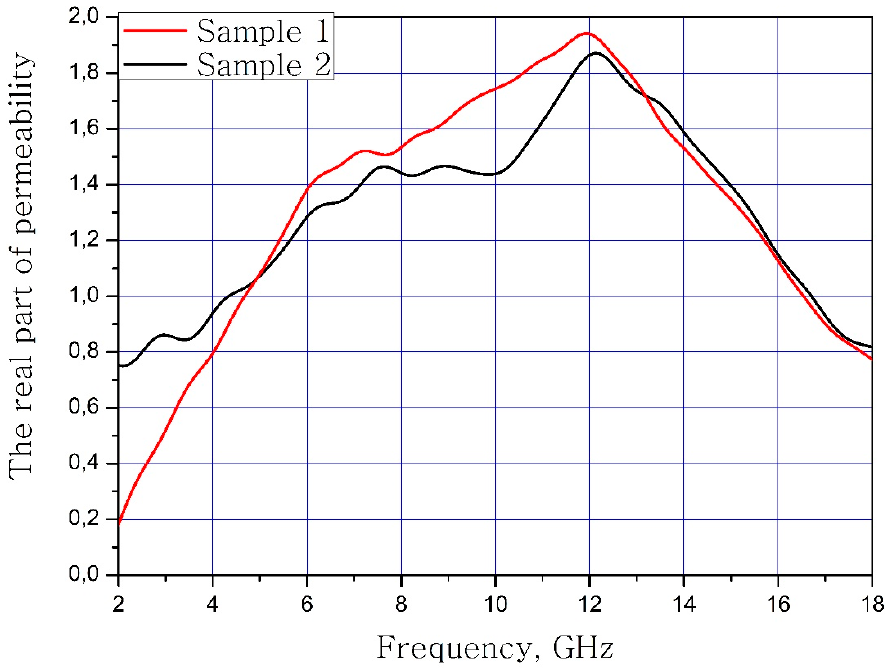
Figure 4. Frequency dependence of the imaginary part of the dielectric permittivity of the samples. The results of calculations of the dependence of the real and imaginary parts for magnetic permeability on the frequency of the material samples are present in Figures 5 and 6.